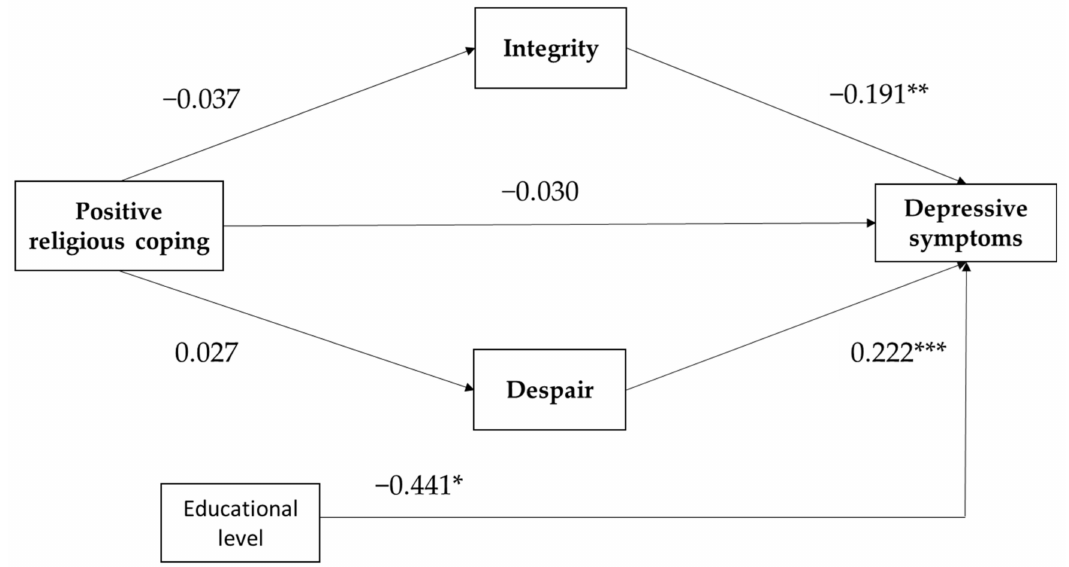
Figure 1. Path model of positive religious coping with depressive symptoms, and with integrity and despair as parallel mediators. Educational level is control variable. All coefficients are unstandardized.